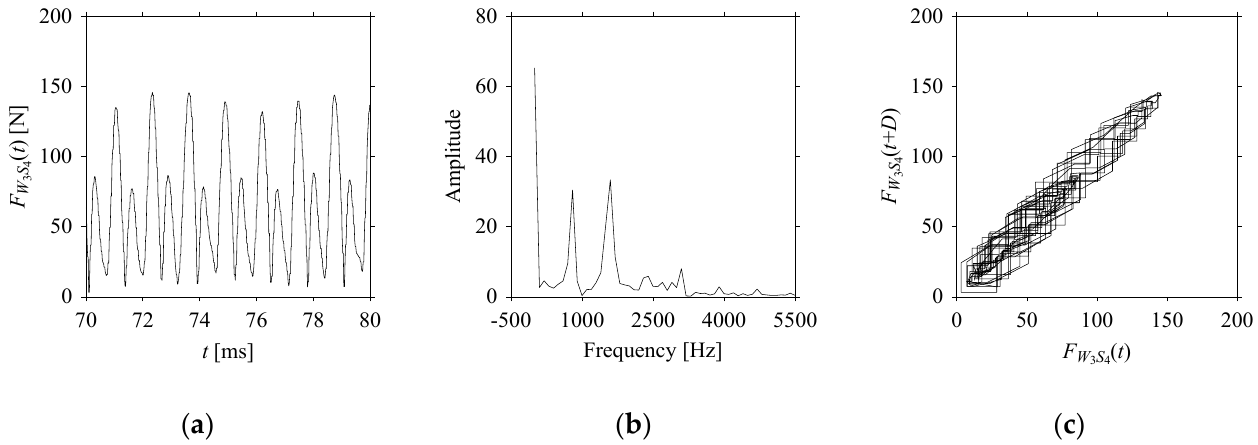
Figure A13. F W in the form of: ( a ) time series, ( b ) fast Fourier Transformation (FFT), and ( c ) delay map ( d = 1). 3 S 4